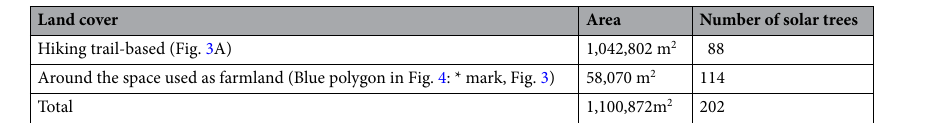
Table 3. Number of solar trees that can be installed.